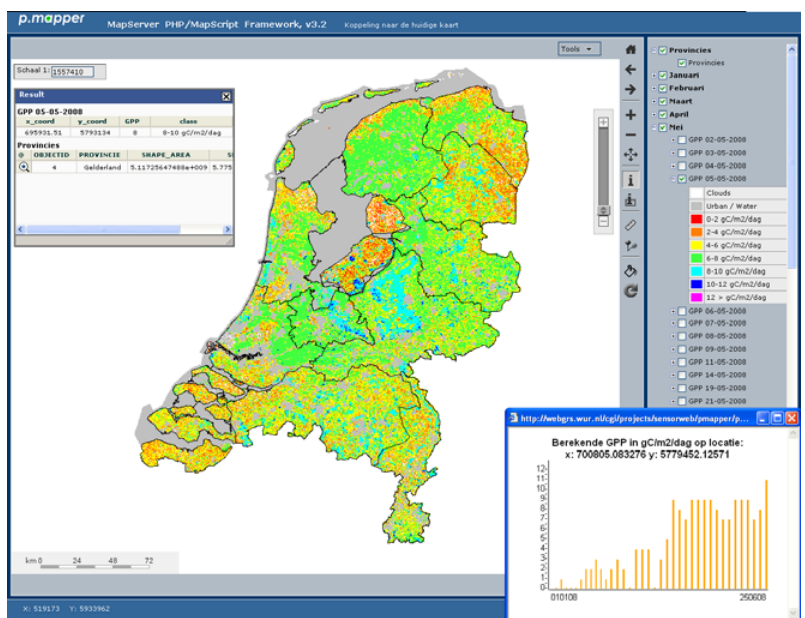
Figure 2. User interface of the dynamic WMS for spatio-temporal development of vegetation productivity over the Netherlands. Vegetation productivity is expressed as GPP in gC m -2 day- 1